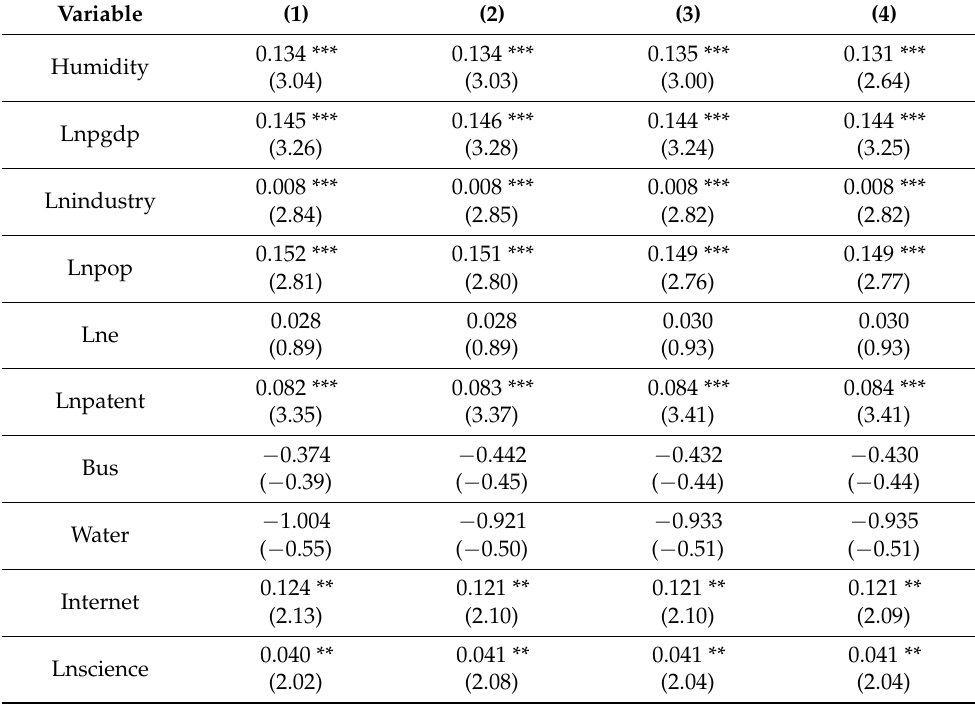
Table A2. Robust results of controlling for more meteorological